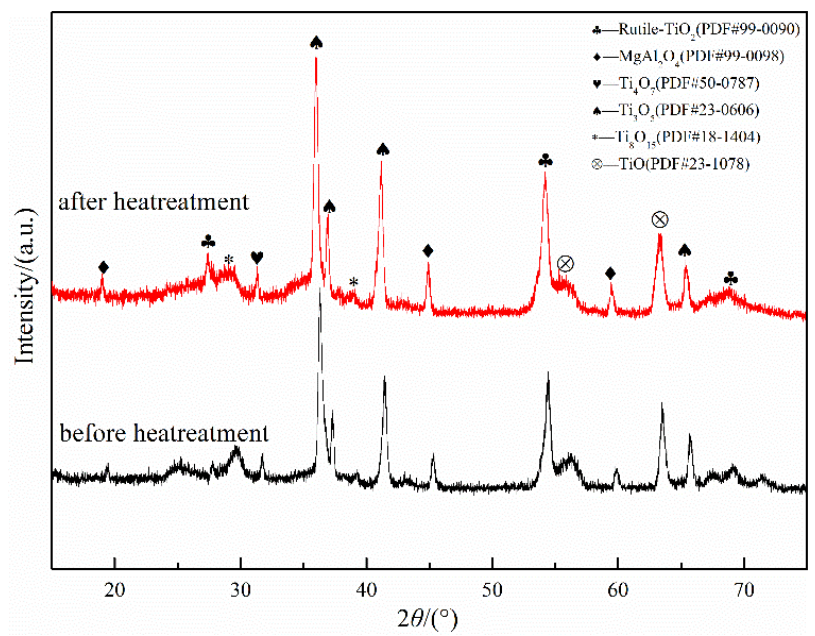
Figure 13. Resistivity – time curves of the cyclic electrification test of heat-treated coatings.